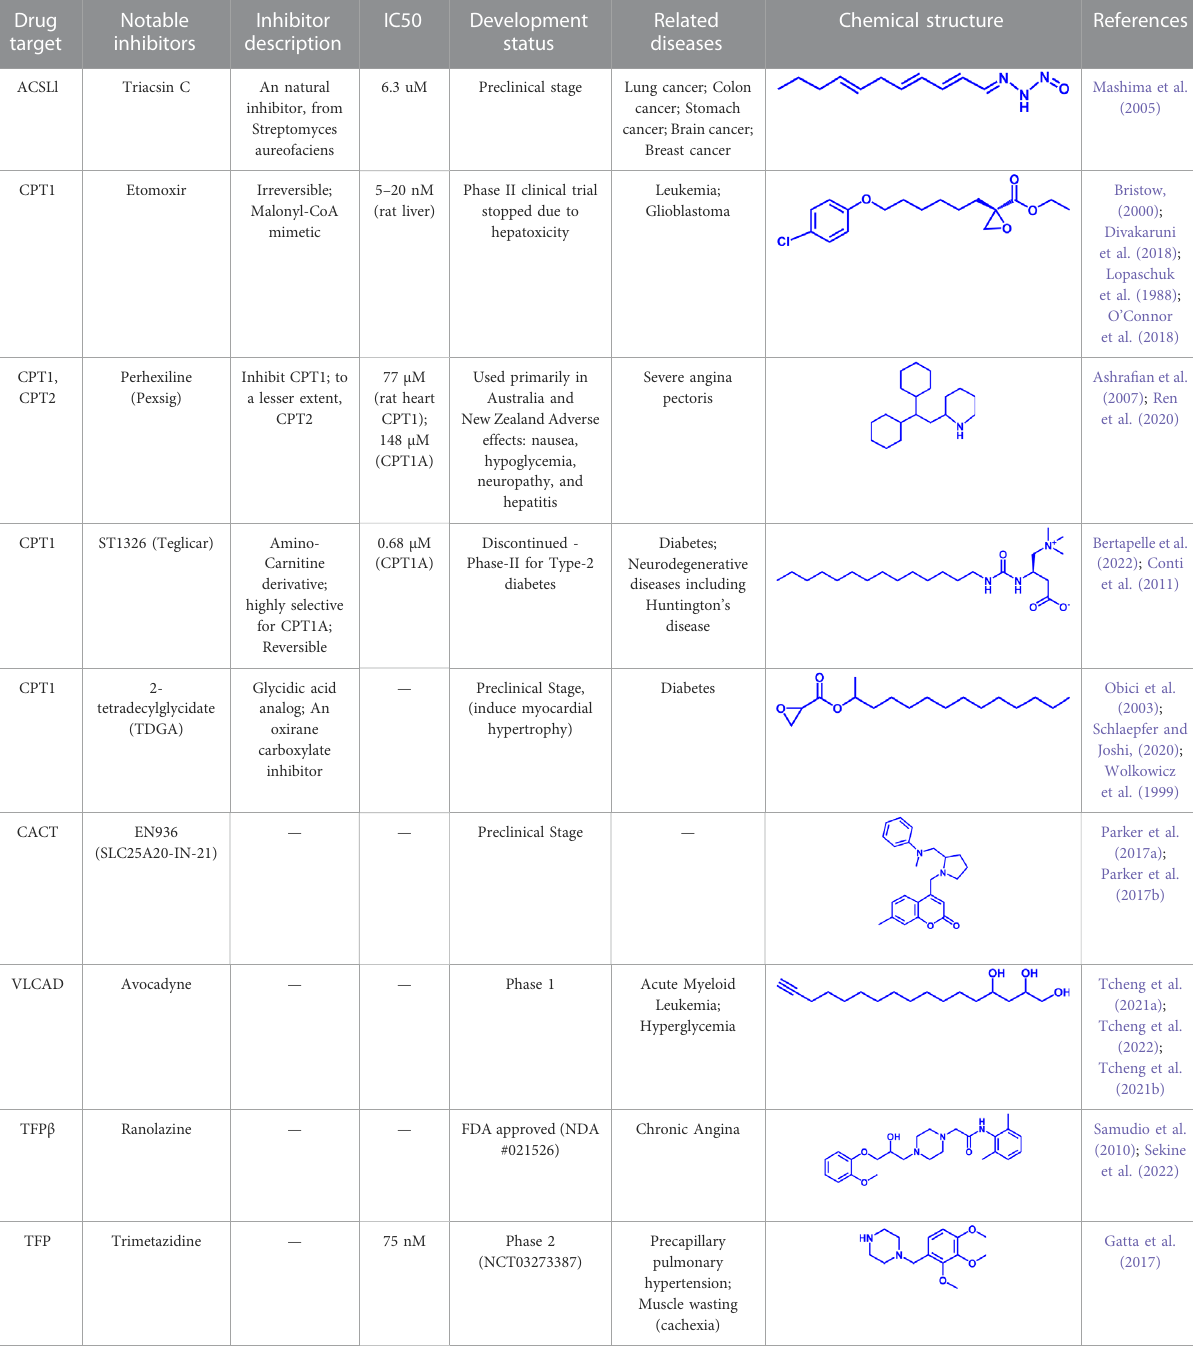
TABLE 4 Potential pharmacological targets and inhibitors targeting